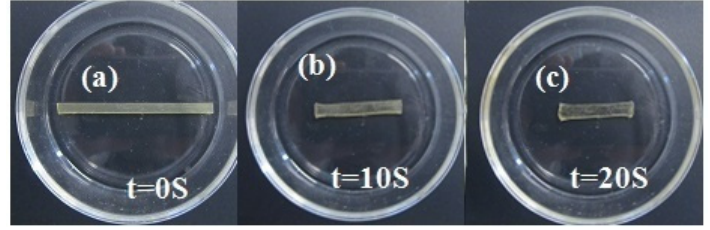
Figure 10. Shape recovery of the 100% extended PEG-H3 at 60 °C. The shape recovery takes place immediately when heated, and completes the process within 20